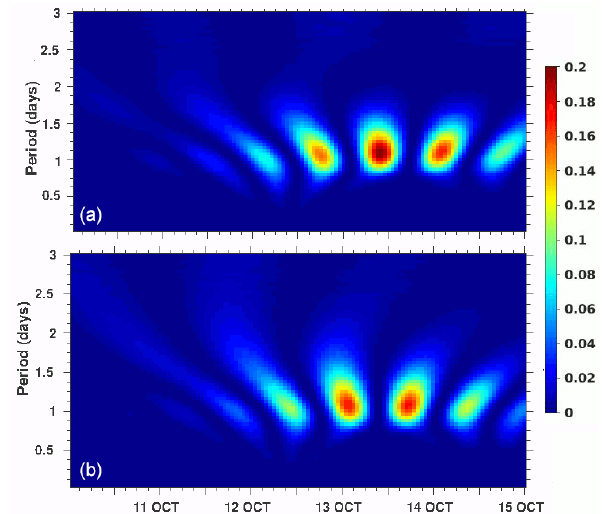
Figure 9. The scalogram by continuous wavelet transform (CWT) method in percentage at 14m depth . Wavelet scalogram shown for the zonal baroclinic current (a) and for the meridional baroclinic current (b)